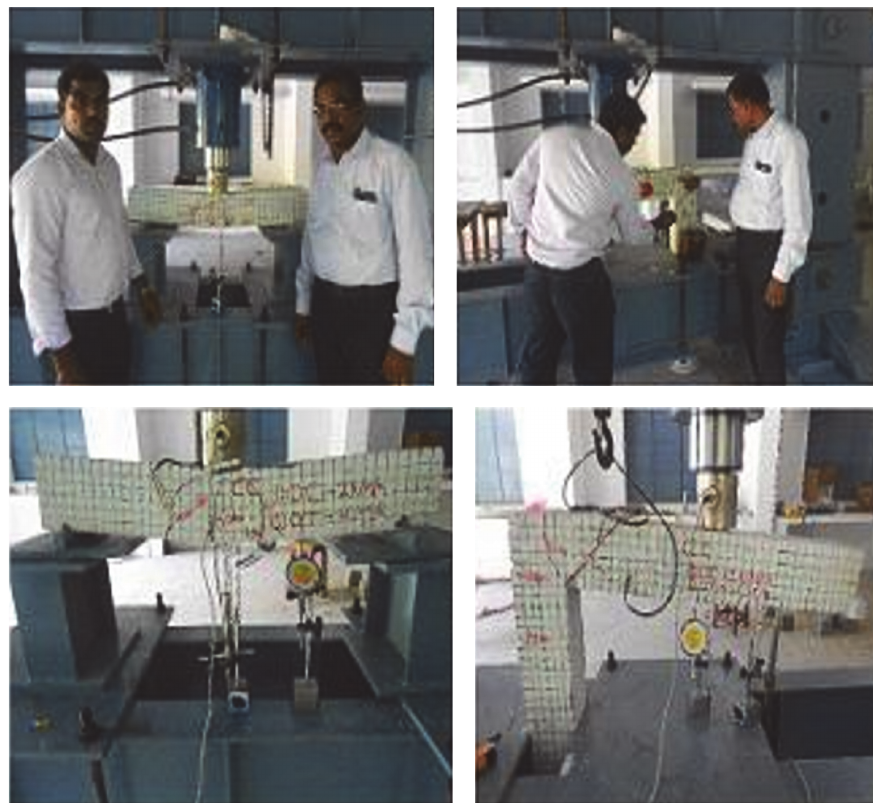
Figure 5: Testing of GPC and CC